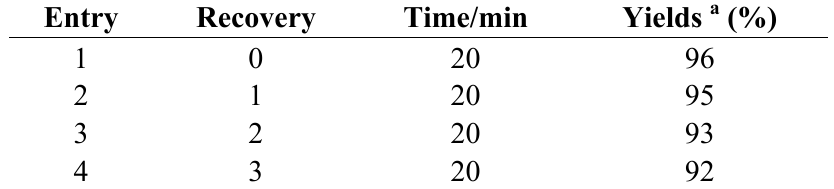
Table 2. Recyclability of the PEG–OSO 2-naphthol with benzaldehyde under neat